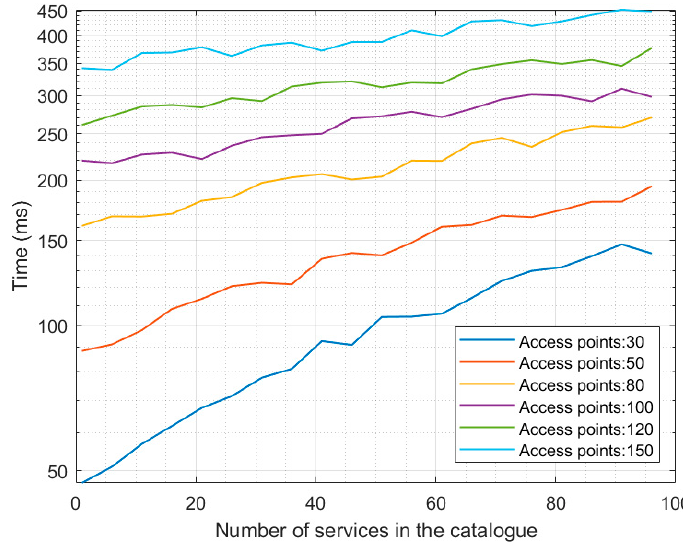
Figure 9. Second experiment: scalability analysis.